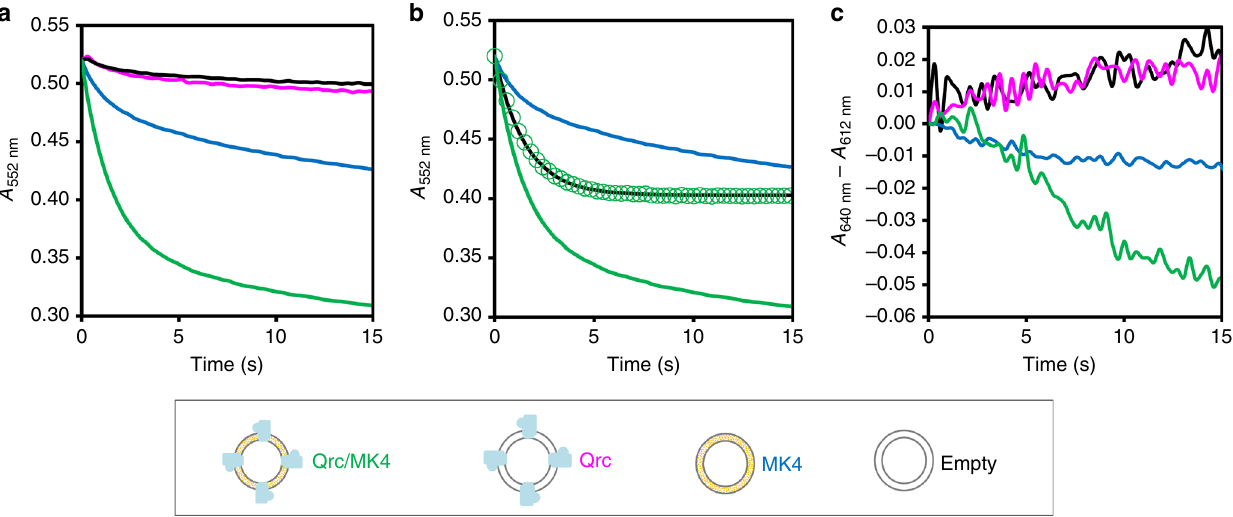
Fig. 2 Electron transfer and membrane potential generation. a Absorbance changes at 552 nm after mixing reduced TpI c 3 with empty liposomes (black), Qrc proteoliposomes (without MK4) (magenta), MK4-liposomes (blue), and Qrc/MK4 proteoliposomes (green). b Kinetic trace subtraction (green circles) of MK4-liposomes data (blue) from that of Qrc/MK4 proteoliposomes (green), fi tted with a single exponential (black line) with equation: ( − 0.12 ± 0.01) × exp (0.65±0.05)× t + (0.40 ± 0.03), where ± gives the standard deviation error obtained from the fi t for each value. c Changes in A 640nm − A 612nm after mixing reduced TpI c 3 with liposomes in the presence of oxonol V. The absorbance presented is the subtraction between liposomes without and with valinomycin (traces used for the subtractions are presented in Supplementary Fig. 6): empty liposomes (black), Qrc proteoliposomes (magenta), MK4- liposomes (blue), and Qrc/MK4 proteoliposomes (green). All traces correspond to the average of at least seven experiments performed with at least